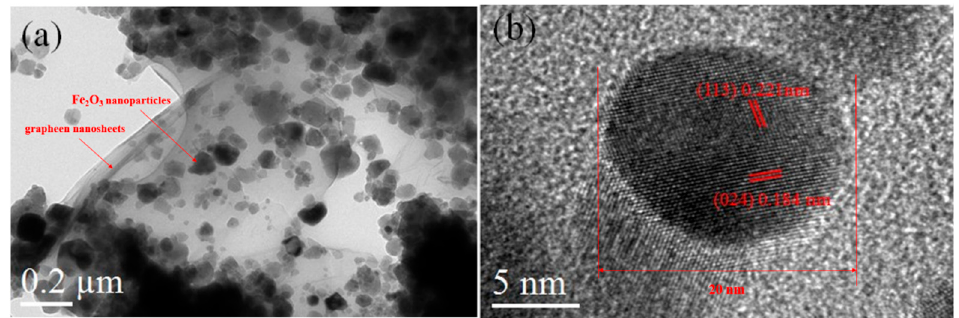
Figure 6. TEM pictures of hybrid flexible paper ( a ) The TEM picture and ( b ) the high-resolution TEM picture of graphene-Fe 2 O 3 sheet.